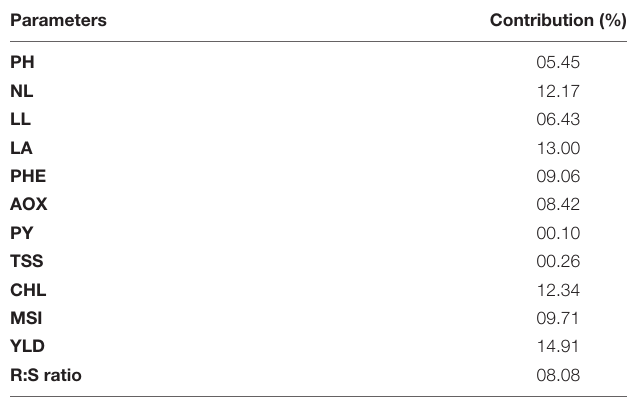
TABLE 10 | Contribution of various parameters toward genetic divergence in 12 contrasting onion